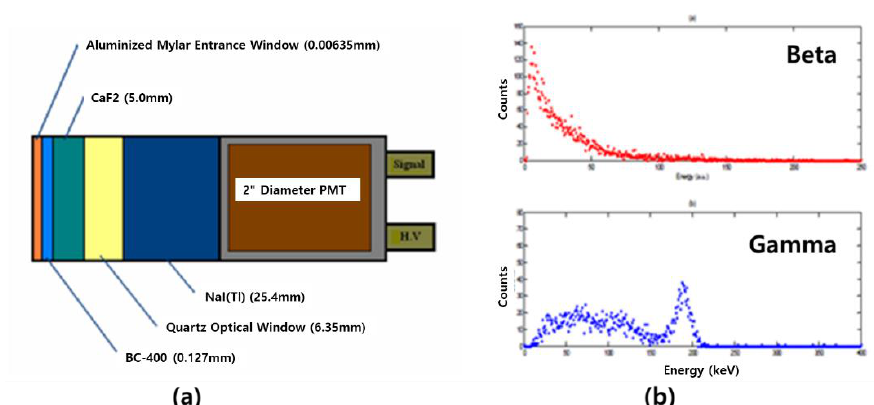
Figure 22. Phoswich detector ( a ) developed by Oregon State University and the filter signal for radiation separation ( b ) [56].